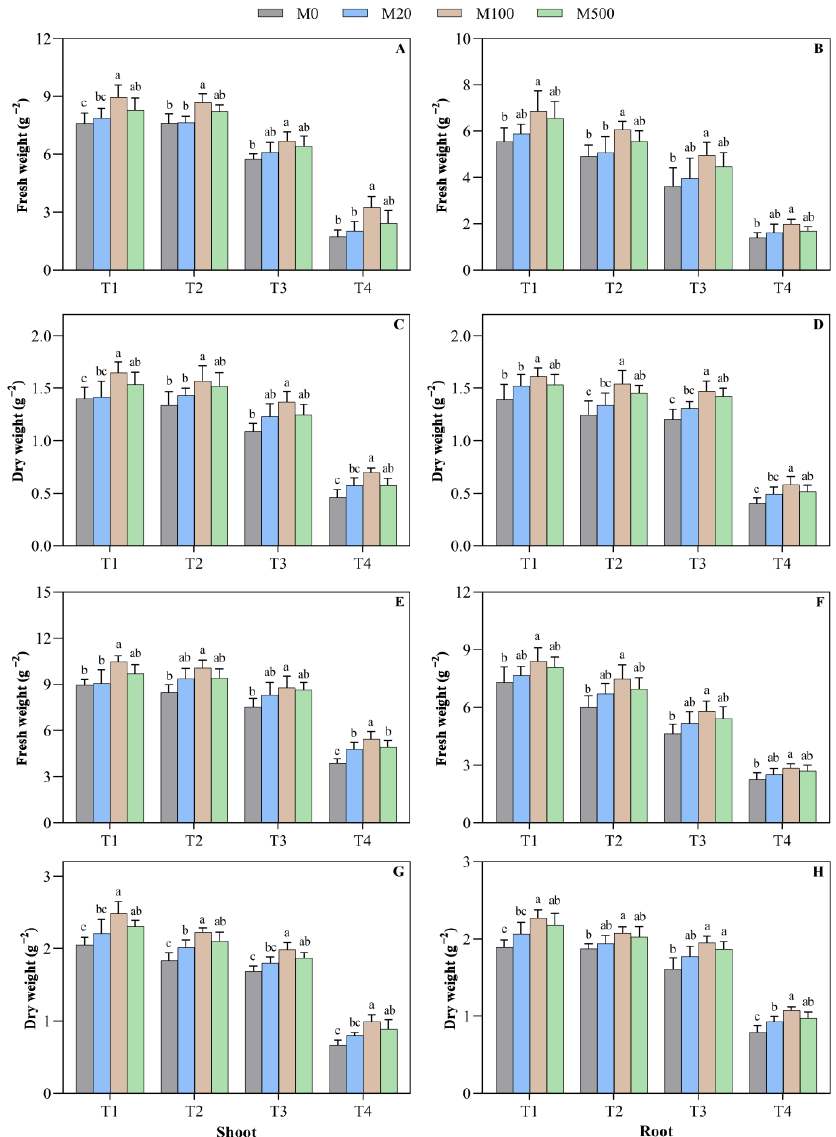
Figure 3. Effects of exogenous melatonin on the rice seed biomass under high temperature stress. Means ± SEs with different letters in each parameter indicate significant statistical differences ( p < 0.05). ( A ) Shoot fresh weight (7 d); ( B ) root fresh weight (7 d); ( C ) shoot dry weight (7 d); ( D ) root dry weight (7 d); ( E ) shoot fresh weight (9 d); ( F ) root fresh weight (9 d); ( G ) shoot dry weight (9 d); and ( H ) root dry weight (9 d).